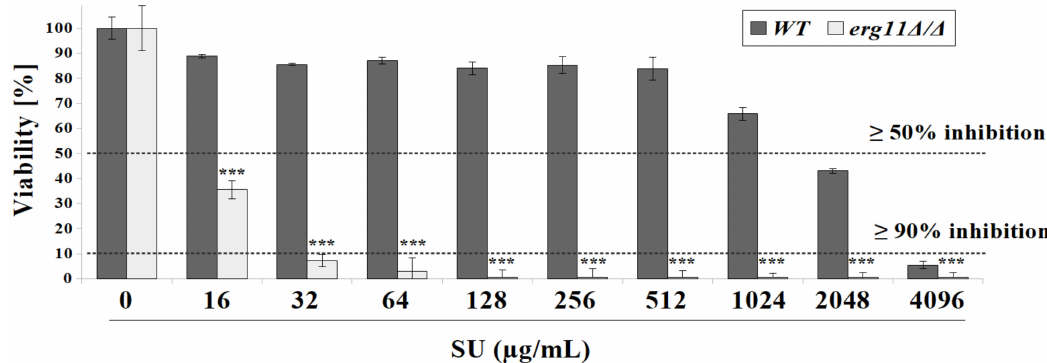
Figure 1. The percent viability of C. albicans CAF2-1 (wild type, WT) and KS028 ( erg11 ∆ / ∆ ) strains after 24 h growth in yeast extract-peptone-dextrose (YPD) in the presence of surfactin (SU) (0–4096 µ g / mL). Concentrations of surfactin (SU, µ g / mL), leading to either ≥ 50 or ≥ 90% growth inhibition towards C. albicans CAF2-1 (WT) and KS028 ( erg11 ∆ / ∆ ) strains were indicated by dashed lines and were equal to 2048 and 16 ( ≥ 50% inhibition) for WT or erg11 ∆ / ∆ , respectively and 4096 and 32 ( ≥ 90% inhibition) for WT or erg11 ∆ / ∆ , respectively. Statistical analyses were performed by comparing viability of the erg11 ∆ / ∆ strain to the viability of the WT strain in correspondence with SU concentrations (means ± SD, n = 6) (*, P < 0.05; **, P < 0.01; ***, P <